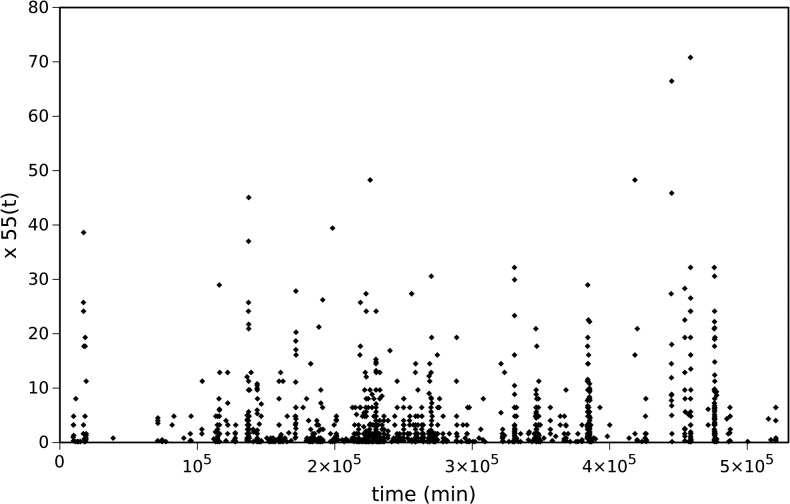
Time series, x
55(t), representation of tornadoes path length, L (km), in year 2005.